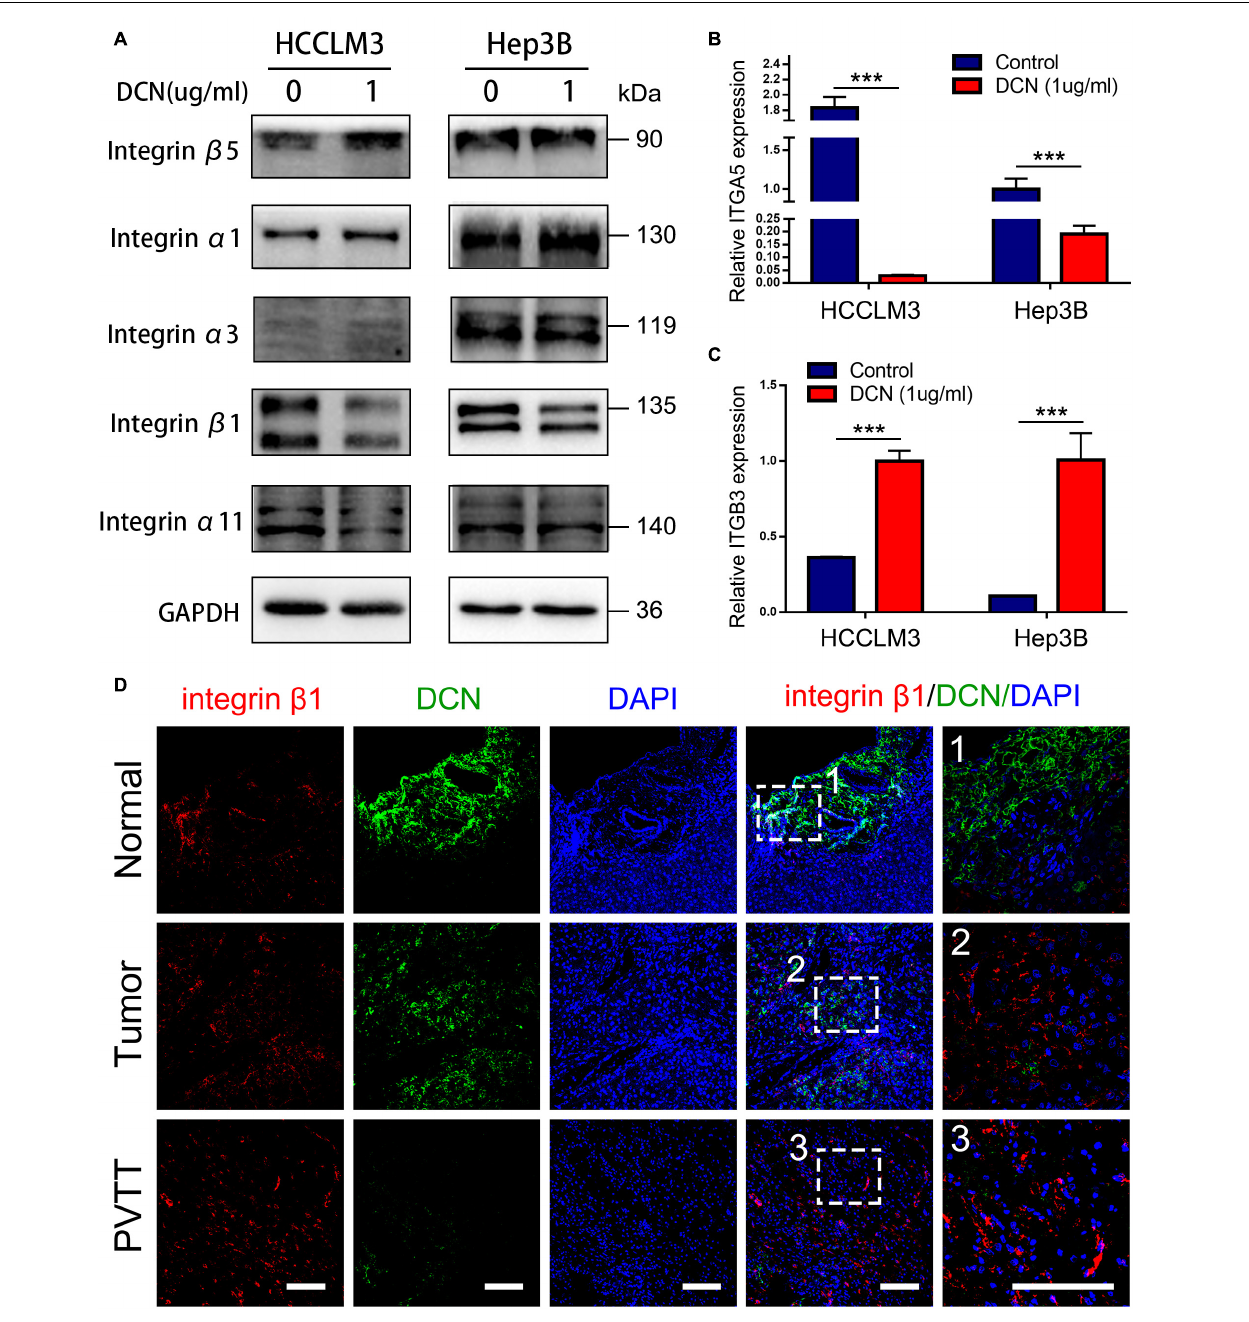
FIGURE 5 | DCN downregulates integrin β 1 expression. (A) Western blot analysis of integrins expression in HCCLM3 and Hep3B cells treated with DCN (1 µ g/mL) or the negative control. (B) qPCR analysis of integrin α 5 expression in HCCLM3 and Hep3B cells treated with DCN (1 µ g/mL) or the negative control. (C) qPCR analysis of integrin β 3 expression in HCCLM3 and Hep3B cells treated with DCN (1 µ g/mL) or the negative control. (D) Representative images of integrin β 1 and DCN expressions in normal tissue, tumor tissue, and PVTT tissue obtained by co-immunofluorescence staining. Scale bar, 100 µ m. ITGA5, integrin α 5; ITGB3, integrin β 3; PVTT, portal vein tumor thrombosis. Data presented as mean ± SEM. *** P < 0.001, Student’s t -test.